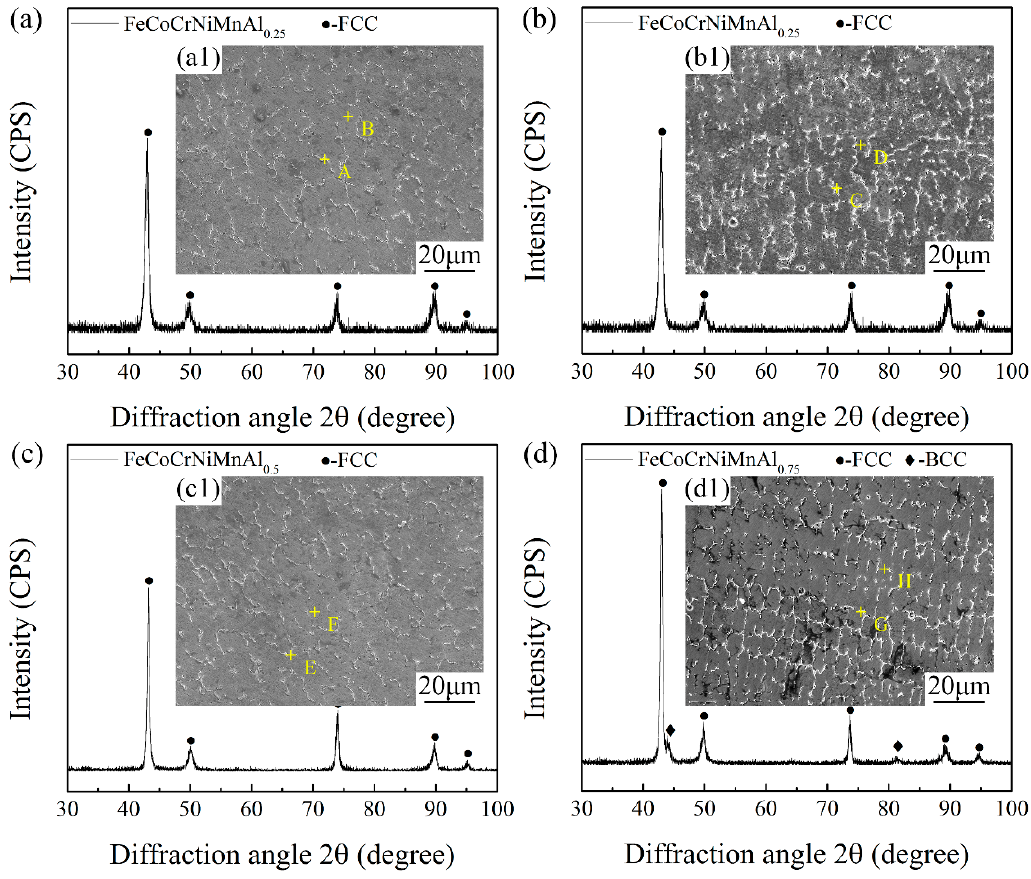
Figure 1. XRD detection results and microstructure of the FeCoCrNiMnAl x cladding layers: ( a , a1 ), x = 0; ( b , b1 ), x = 0.25; ( c , c1 ), x = 0.5; and ( d , d1 ), x = 0.75.